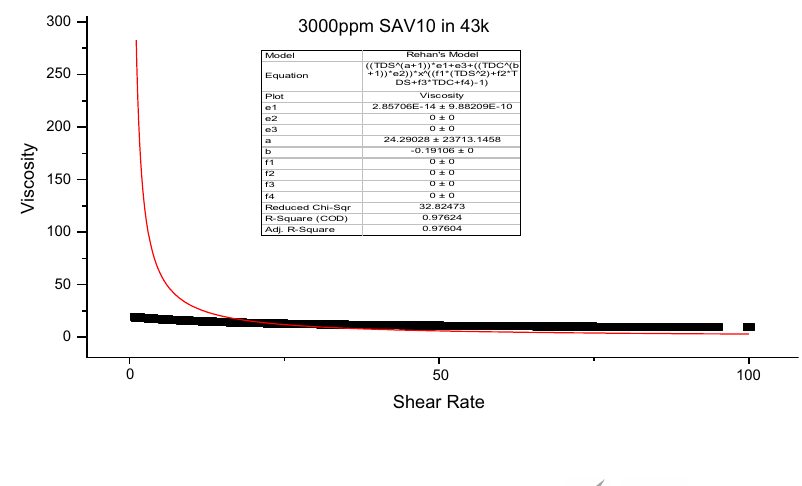
Fig. 18 Results of a power law modification for SAV10